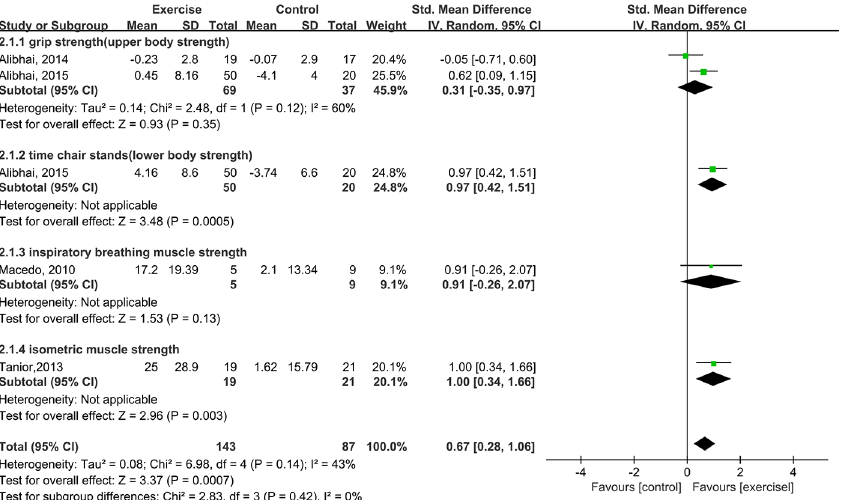
Fig 5. Forest plot comparing the changes in muscle strength between the exercise and control